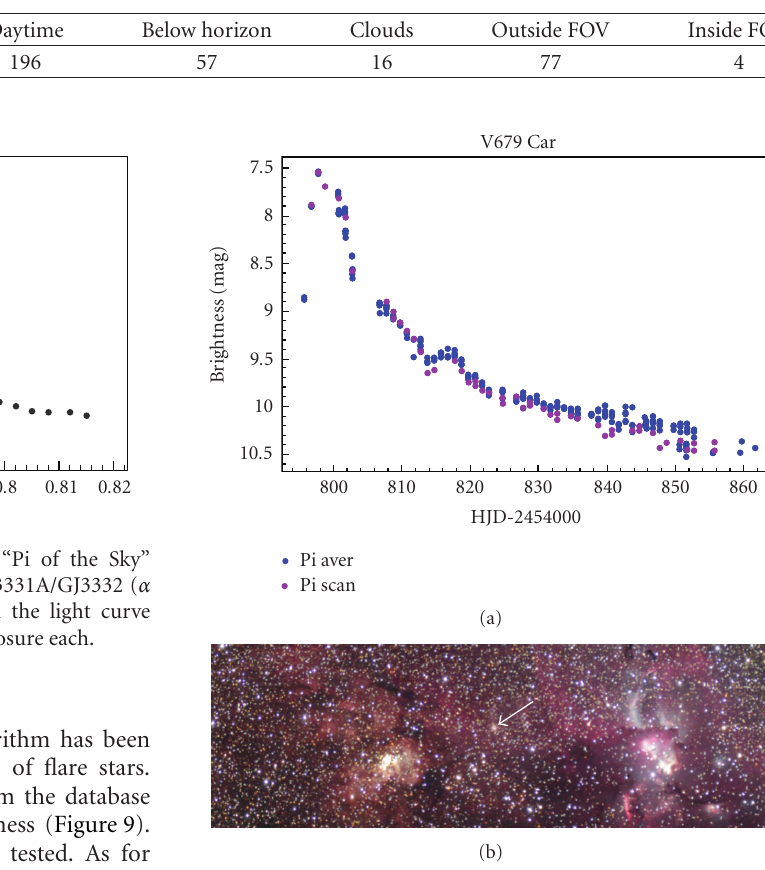
Table 1: Statistic of “Pi of the Sky” observations.